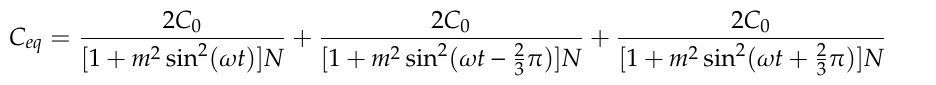
Figure 5. Relationship between discharging coefficient and fault time (m = 0.93).